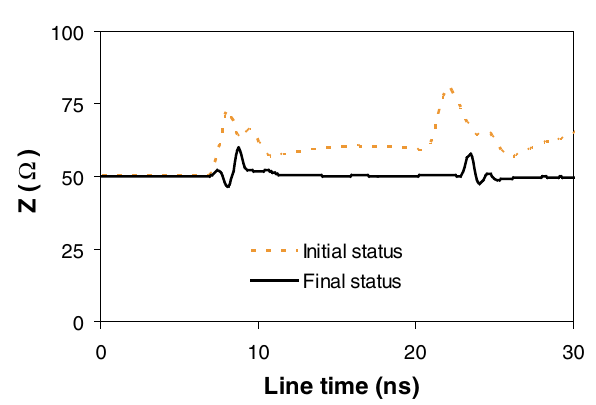
FIG. 8. (Color) Bottom part of the chamber, where we can see the transition pieces between the feedthrough and the six wires. The joint is made of Cu, while the transition star is made on Cu-Be. The transition star has six arms, corresponding to the six inner wires, but only two of them are drawn here. Lengths are given in